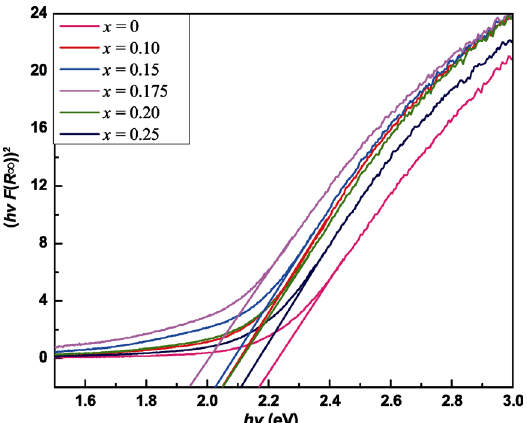
Fig. 6 Complex impedance plane plots of